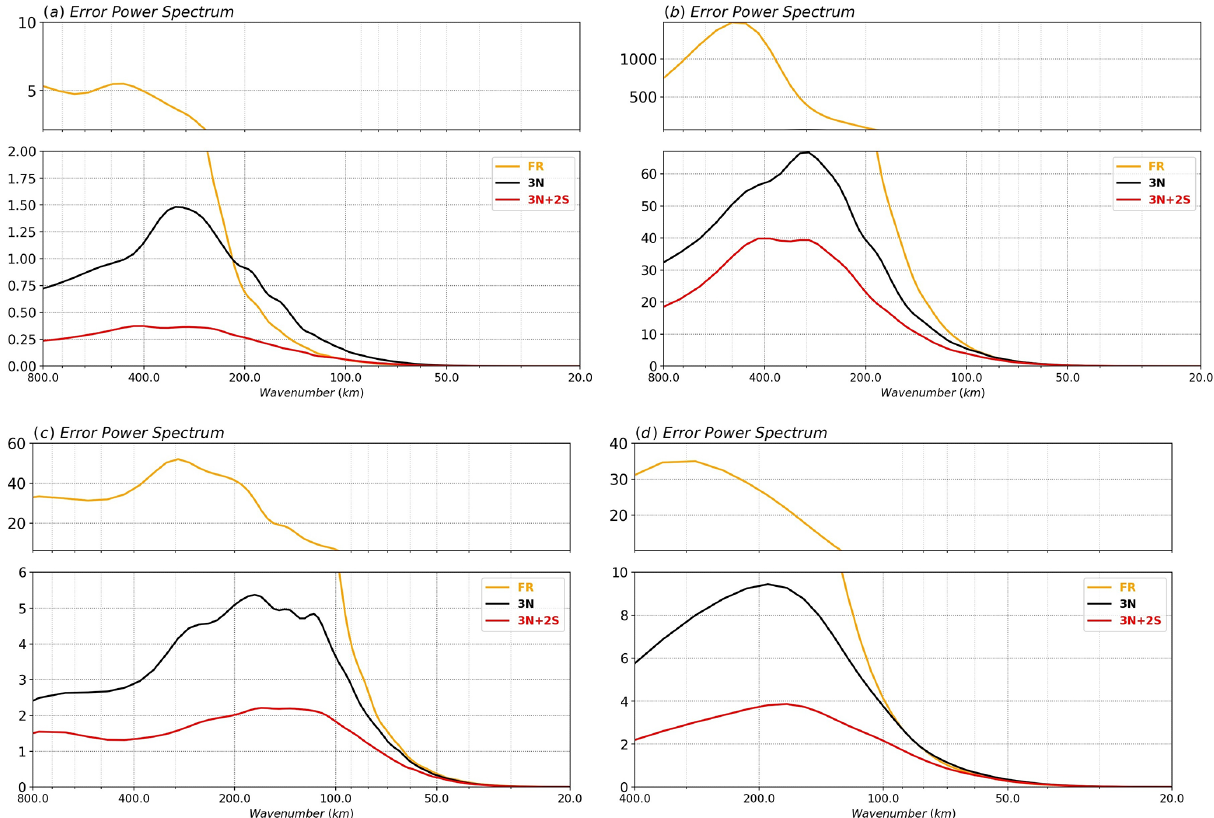
Figure 10. Power spectra SSH error with respect to the NR; the spectra are shown in a variance preserving form (cm 2 ), (a) low-latitude region (red box in Fig. 3), (b) Agulhas current (orange box in Fig. 3), (c) North Atlantic (high-latitude, green box in Fig. 3) and (d) North Atlantic Drift current (black box in Fig.